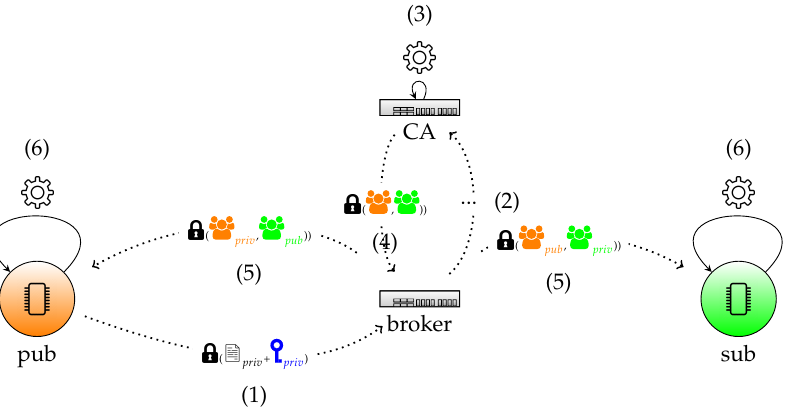
Figure 2. Certificate request and reception between a client node and a broker communicating with a certificate authority. (1) ECQV request of device, (2) ECQV request of client forwarded by broker to CA, (3) ECQV response of CA, (4) ECQV response forwarded by broker to device, (5) Reception and verification of device